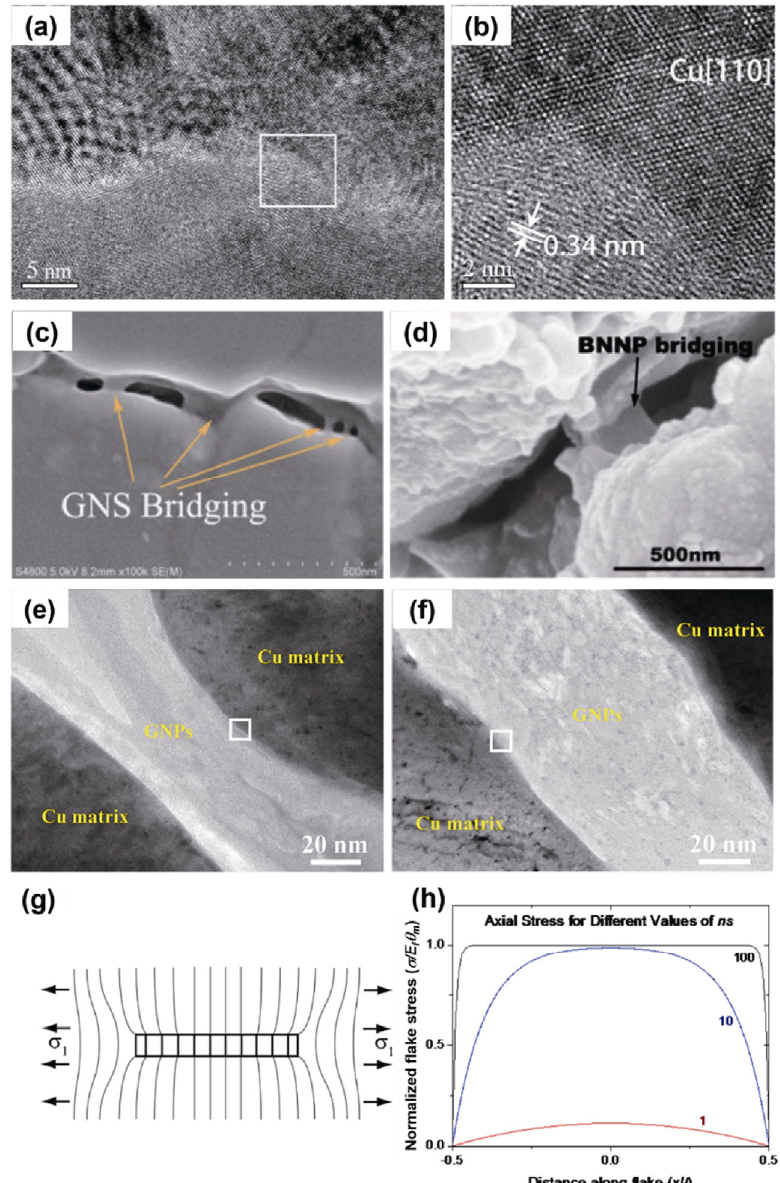
Fig. 16 Typical interface between graphene and copper matrix: (a, b) the interplanar distance of graphene is 0.34 nm. Reproduced with permission from Ref. [204], © American Chemical Society 2015. Bridging of 2D materials in composite systems: (c) graphene bridging. Reproduced with permission from Ref. [166], © Elsevier Ltd and Techna Group S.r.l. 2015. (d) BN bridging. Reproduced with permission from Ref. [36], © The Authors 2019. (e, f) Graphene bridging. Reproduced with permission from Ref. [49], © Elsevier B.V. 2018. (g, h) Deformation patterns of 2D material in a matrix under axial stress σ 1